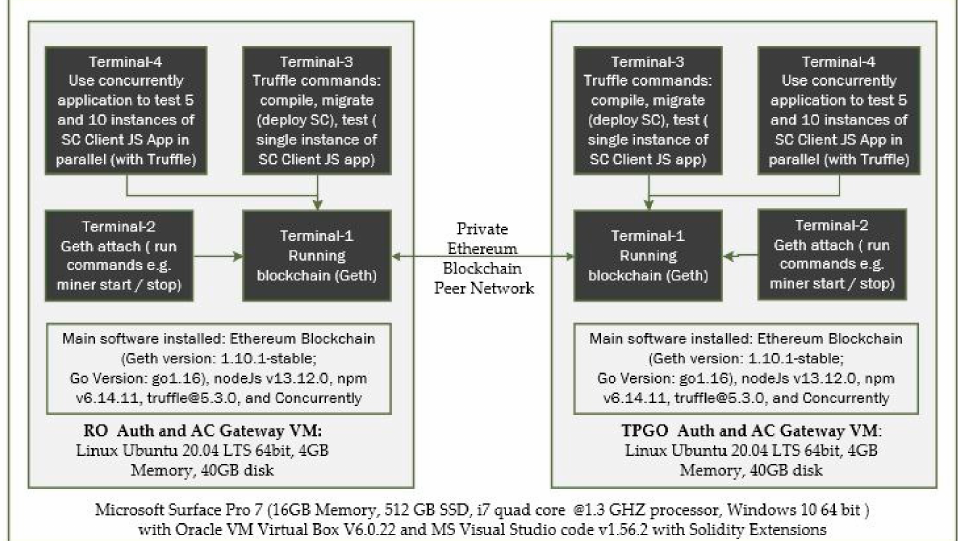
Figure 10. Experimental set-ups for a private Ethereum blockchain